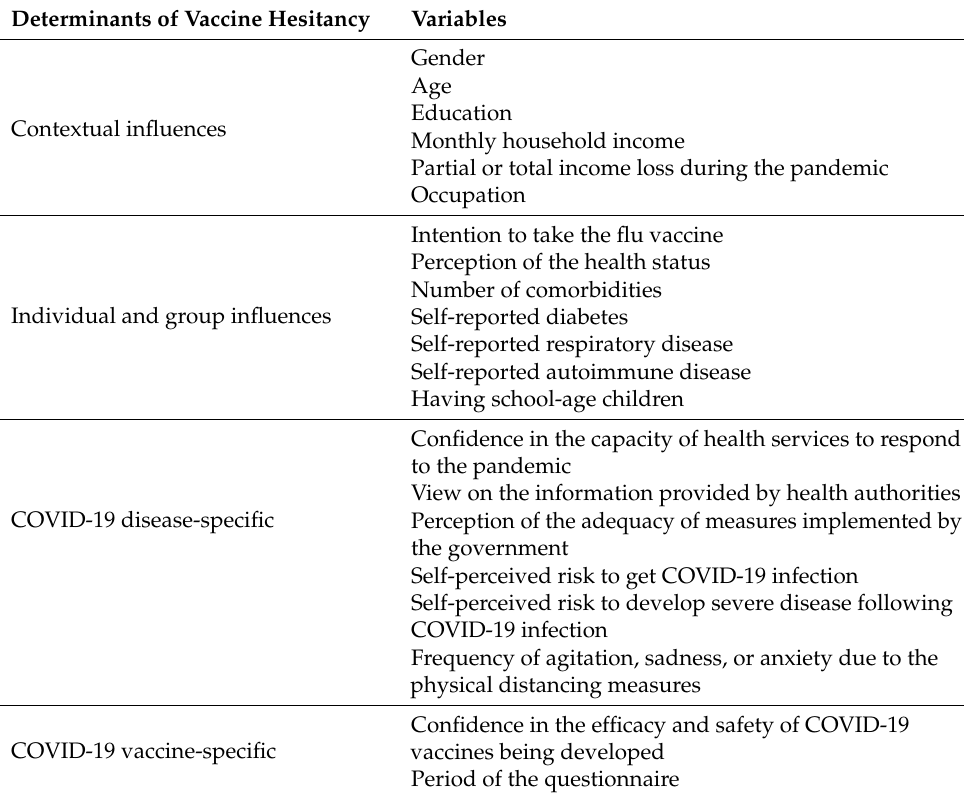
Table 1. Vaccine hesitancy determinant matrix recommended by the Strategic Advisory Group of Experts (SAGE) Working Group on Vaccine Hesitancy [2], with the fourth category specific to the COVID-19